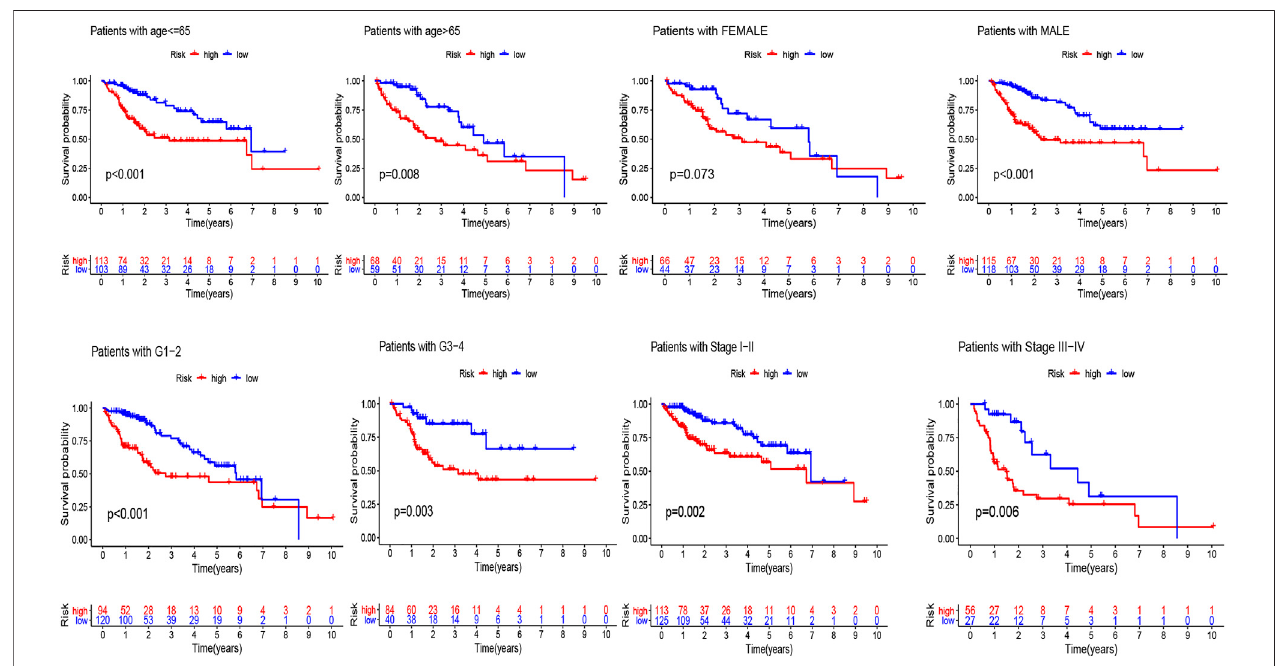
FIGURE 5 | Kaplan-Meier analyses for the two subgroups (high-risk vs low-risk) categorized by clinical variables, comprising age, gender, grade, and stage.